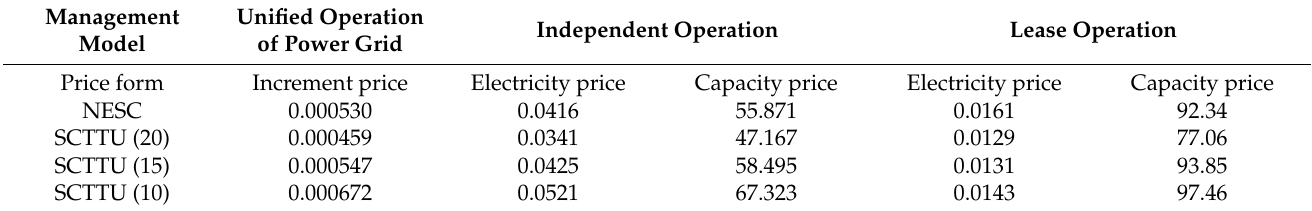
Table 2. Price summary for unified operation, independent operation, and lease operation (yuan/(kVarh)).